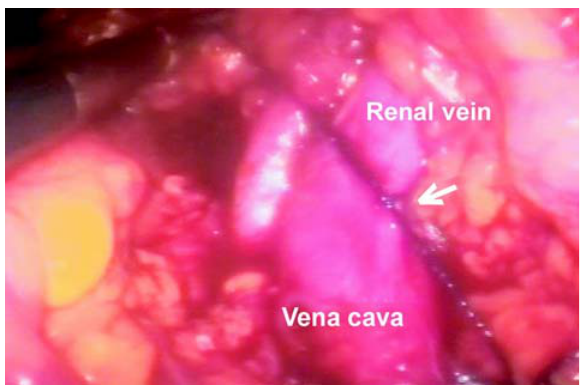
Figure 10 – Retroperitoneoscopic right renal vein ligature with cotton 2-0 suture